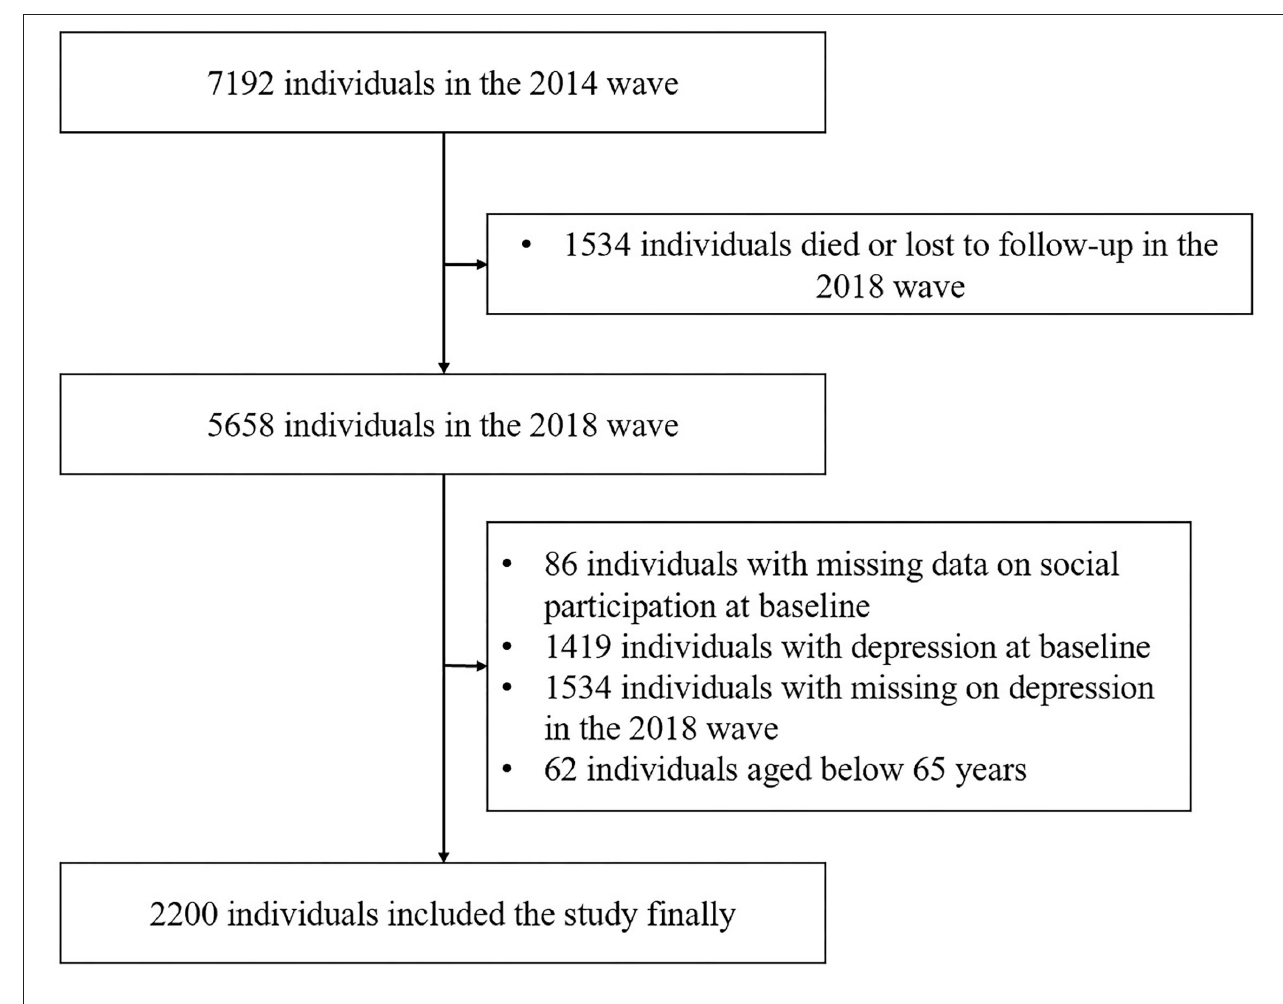
FIGURE 1 | Flowchart of participant